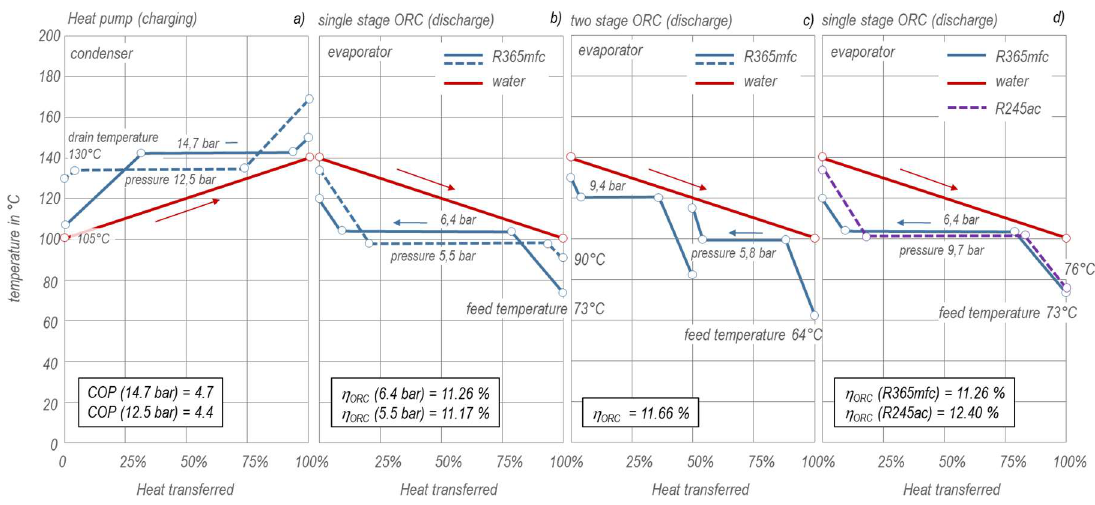
Figure 5. Impact of compressor and ORC evaporator feed temperatures ( a , b ), staged evaporation ( c ) selection of the working fluid ( d ) on COP and thermal efficiency of the Rankine cycle (temperature spread of the water storage 140 °C/100 °C, isentropic efficiencies of compressors and expanders 70%, waste heat temperature 80 °C, ambient/ORCs condenser temperature 40 °C, terminal temperatures at the pinch points 5 K).